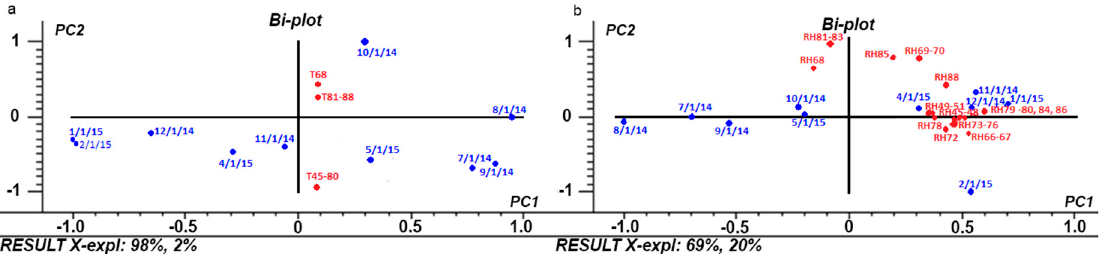
Figure 2. PCA Bi-plot (scores and loadings). ( a ) Tempera–ture PC1-PC2; ( b ) Relative Humidity PC1-PC2. Legend: blue color (scores), red color (loadings), X-expl refers to the percentage of variability of each sensor ( X ) explained by components 1 (PC1) and 2 (PC2), respectively.